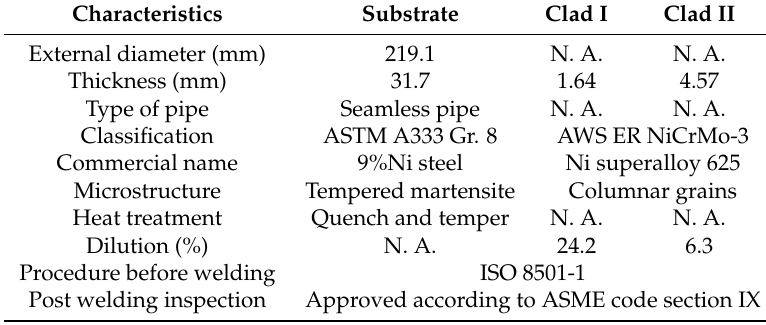
Table 2. Characteristics of a quenched and tempered 9%Ni (ASTM A333 Gr. 8) steel pipe cladded with